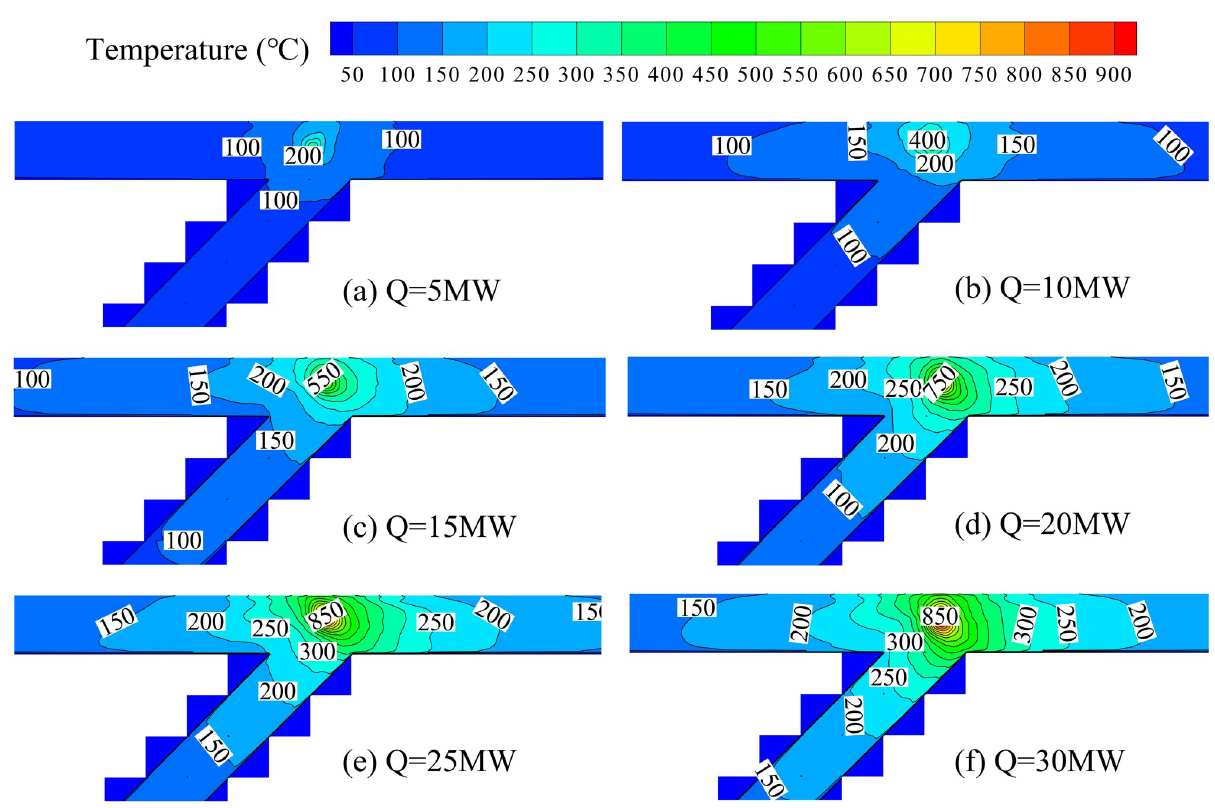
Fig 5. Temperature contours for various HRR at bifurcation angle of 45˚ (top